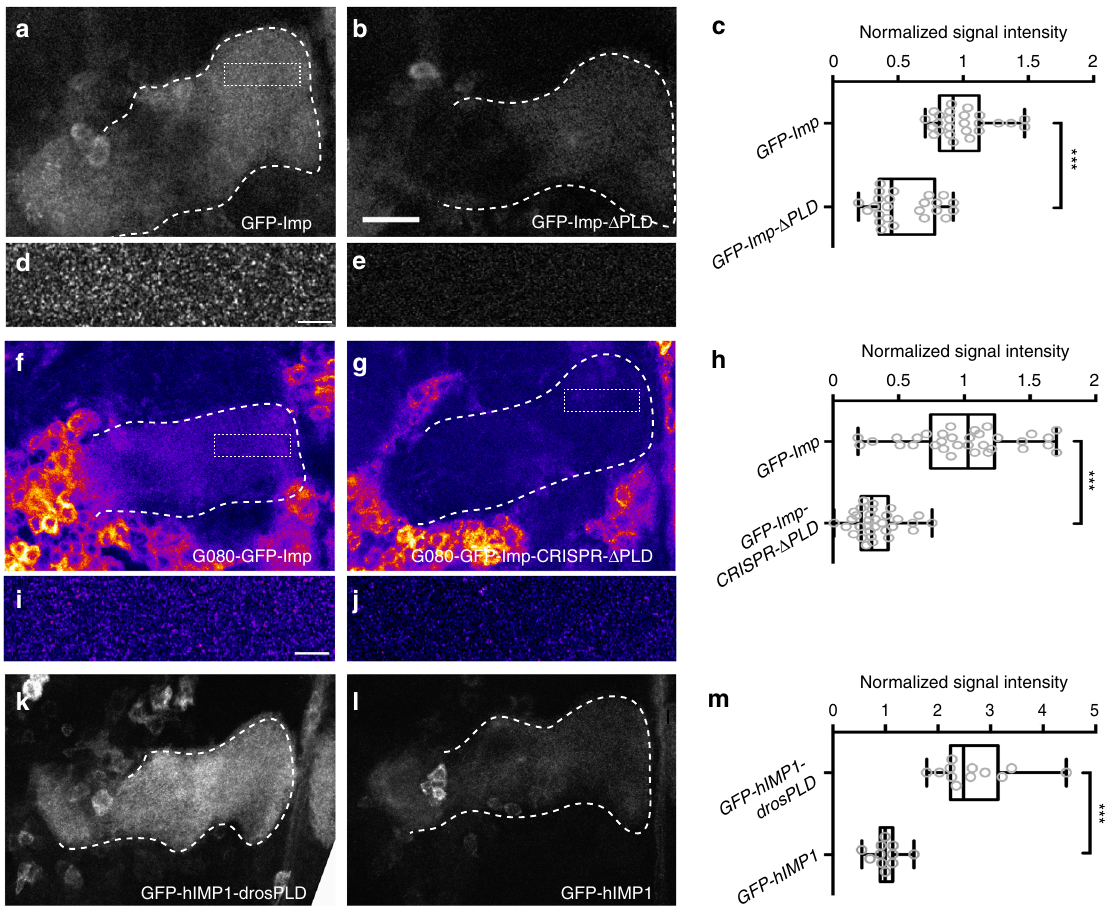
Fig. 3 Imp PLD promotes ef fi cient localization to axons in vivo. a , b Medial lobes of adult brains expressing GFP-Imp ( a ) or GFP-Imp- Δ PLD ( b ) under the control of the 201Y-Gal4 driver. c Distributions of normalized GFP signal intensities in distal axons. d , e Magni fi ed views of the distal region of medial γ lobes expressing GFP-Imp ( d ) or GFP-Imp-KH1 – 4DD ( e ), a form that cannot bind RNA and does not form granules (see Fig. 5). GFP-Imp-KH1 – 4DD is used to show the speci fi city of the granular pattern. Note that the image shown in d was not taken from the brain shown in a . Still, the approximate position of the magni fi ed region is boxed in a . f , g Medial lobes of adult brains homozygous for the G080-GFP-Imp ( f ) or G080-GFP-Imp-CRISPR- Δ PLD ( g ) chromosomes. Note that the cell bodies of surrounding cells also expressing Imp are visible in f , g . GFP signals are shown with the Fire look-up table of ImageJ. h Distributions of normalized GFP signal intensities in distal axons. i , j Magni fi ed views of the distal region of G080-GFP-Imp ( i ) or G080-GFP-Imp- CRISPR- Δ PLD ( j ) medial γ lobes. Note that images in i , j were not taken from the brains shown in f , g . Still, the approximate position of the magni fi ed regions is boxed in f , g . Distributions of normalized GFP signal intensities in distal axons. k , l Medial lobes of adult brains expressing GFP-hIMP1-drosPLD ( k ) or GFP-hIMP1 ( l ) under the control of the 201Y-Gal4 driver. m Distributions of normalized GFP signal intensities in distal axons. The dashed lines in a – l delimit the distal part of MB γ axon bundles (medial lobes; see Fig. 2a). Genotypes: 201Y-Gal4/UAS-GFP-Imp ( a , d ); 201Y-Gal4/UAS-GFP-Imp- Δ PLD ( b ); using the min to max convention, where the middle line de fi nes the median and the whiskers go down to the smallest value and up to the largest.